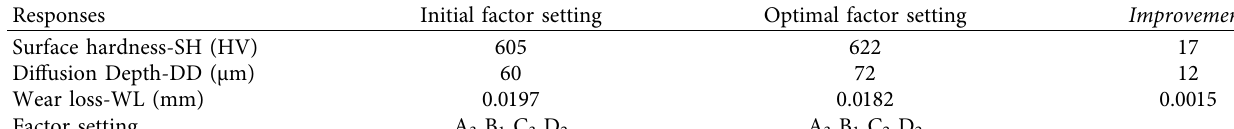
Table 5: Responses from predicted optimal setting and initial setting of parameters.